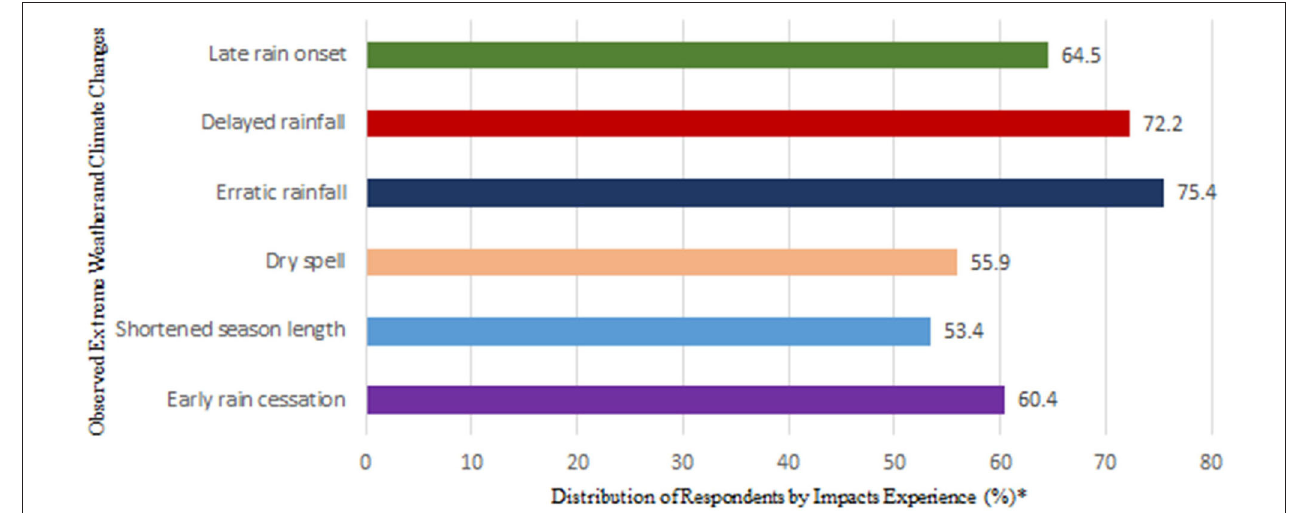
FIGURE 2 | Distribution of most impactful weather and climate changes in the past 5